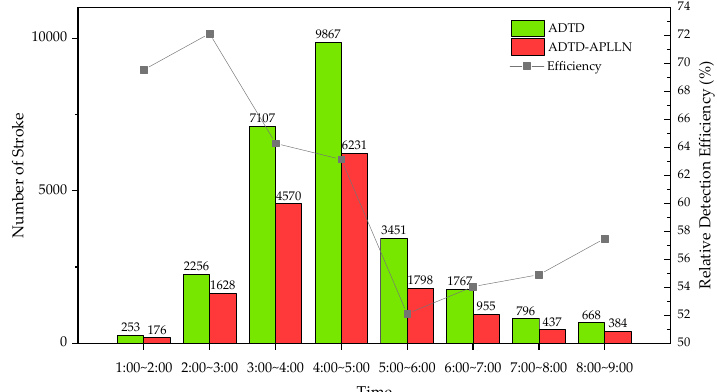
Figure 14. Distribution of lightning quantity and detection efficiency at different periods. The green bars represent the detection results of ADTD in different time periods, the red bars represent the number of shared events between ADTD and APLLN in different time periods, and the points and lines represent the detection efficiency of APLLN relative to ADTD.